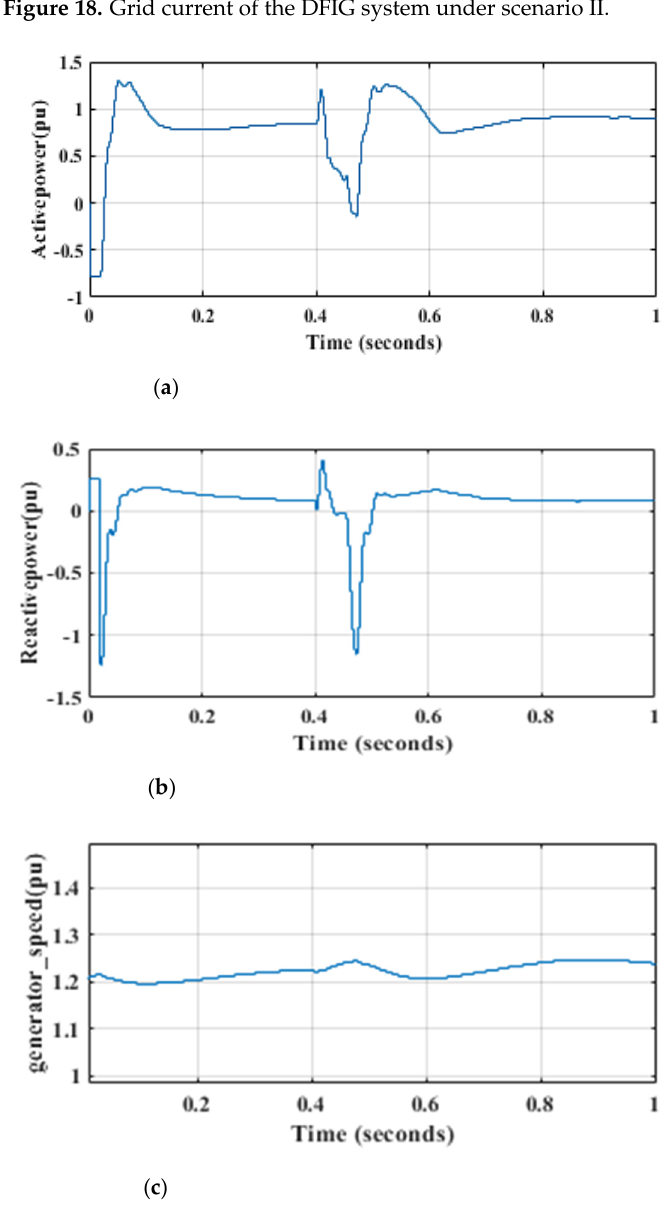
Figure 19. The DFIG responses according to scenario II ( a ) measured active power of the DFIG WT, ( b ) measured reactive power of the DFIG WT, ( c ) generator speed of the DFIG system.